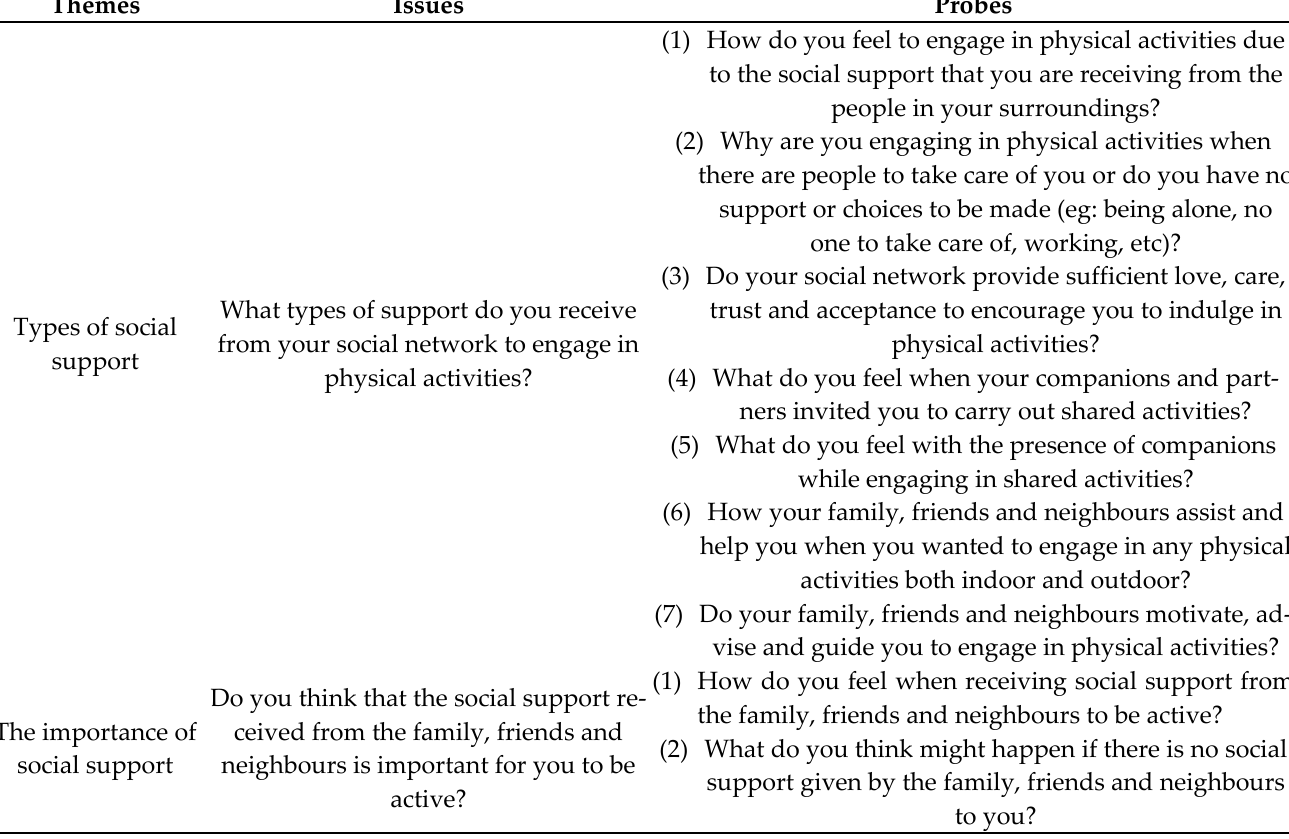
Table 1. Semi-structured interview guide and